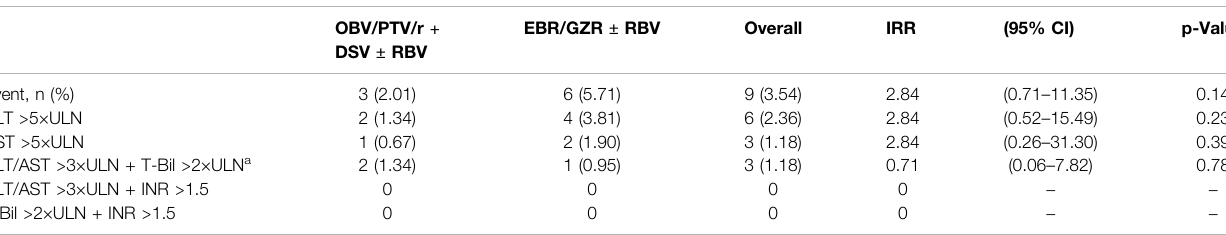
TABLE 3 | Incidence of the drug-induced liver injury adverse